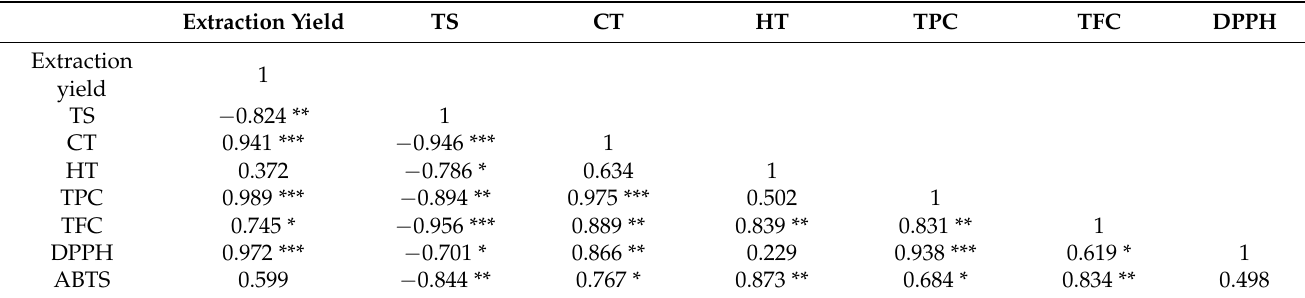
Table 2. Pearson’s linear correlation matrix between each pair of variables.